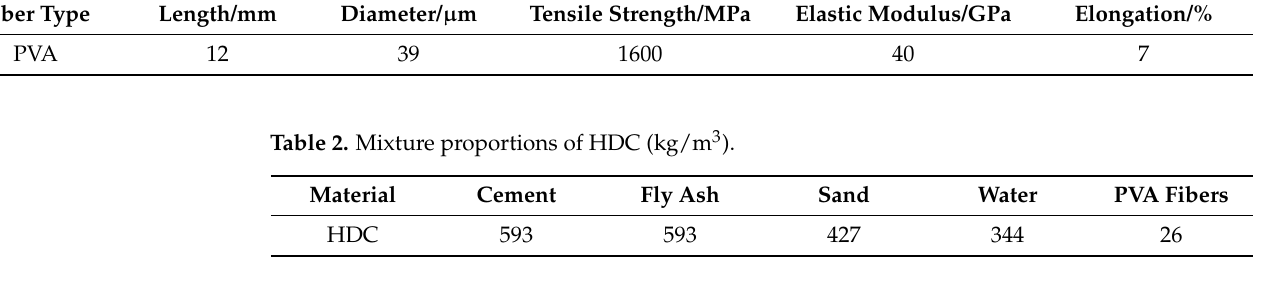
Table 1. Properties of PVA fibers.